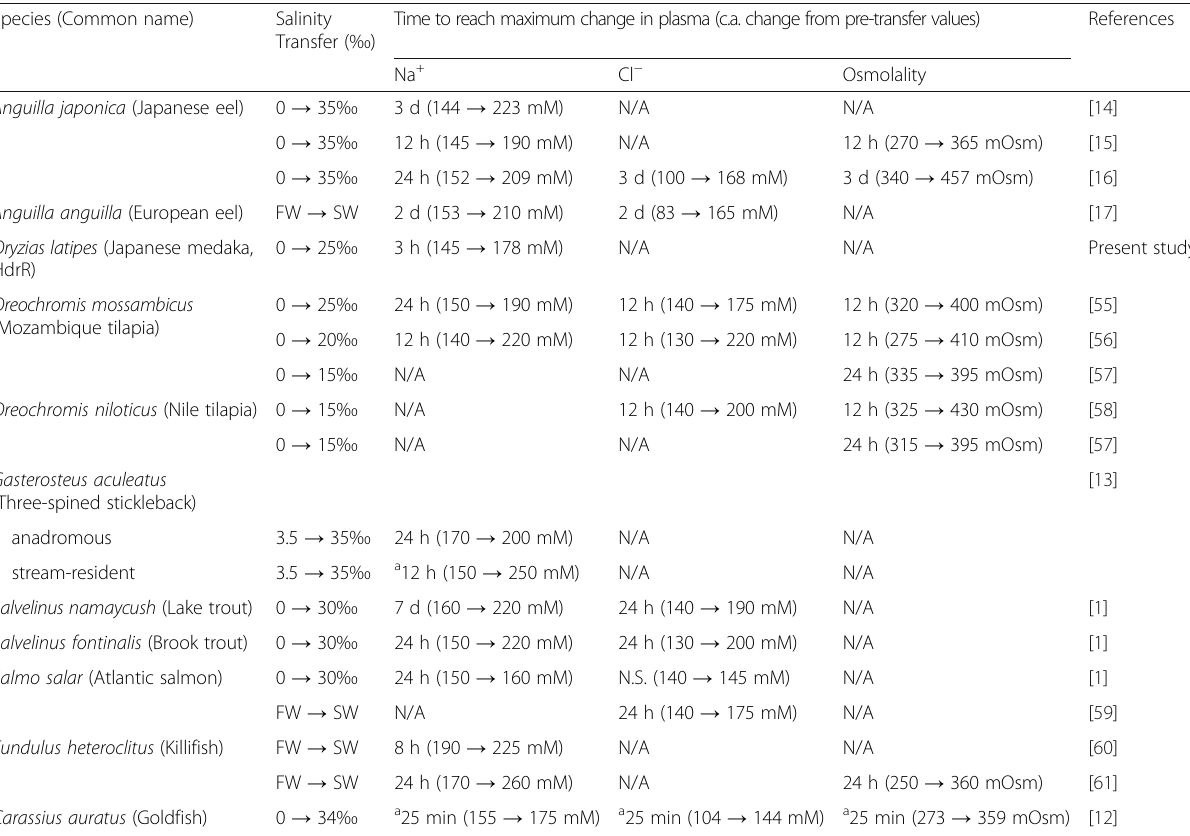
Table 1 Effects of salinity transfer on the levels of plasma Na + , Cl − , and osmolality in common teleost models Species (Common